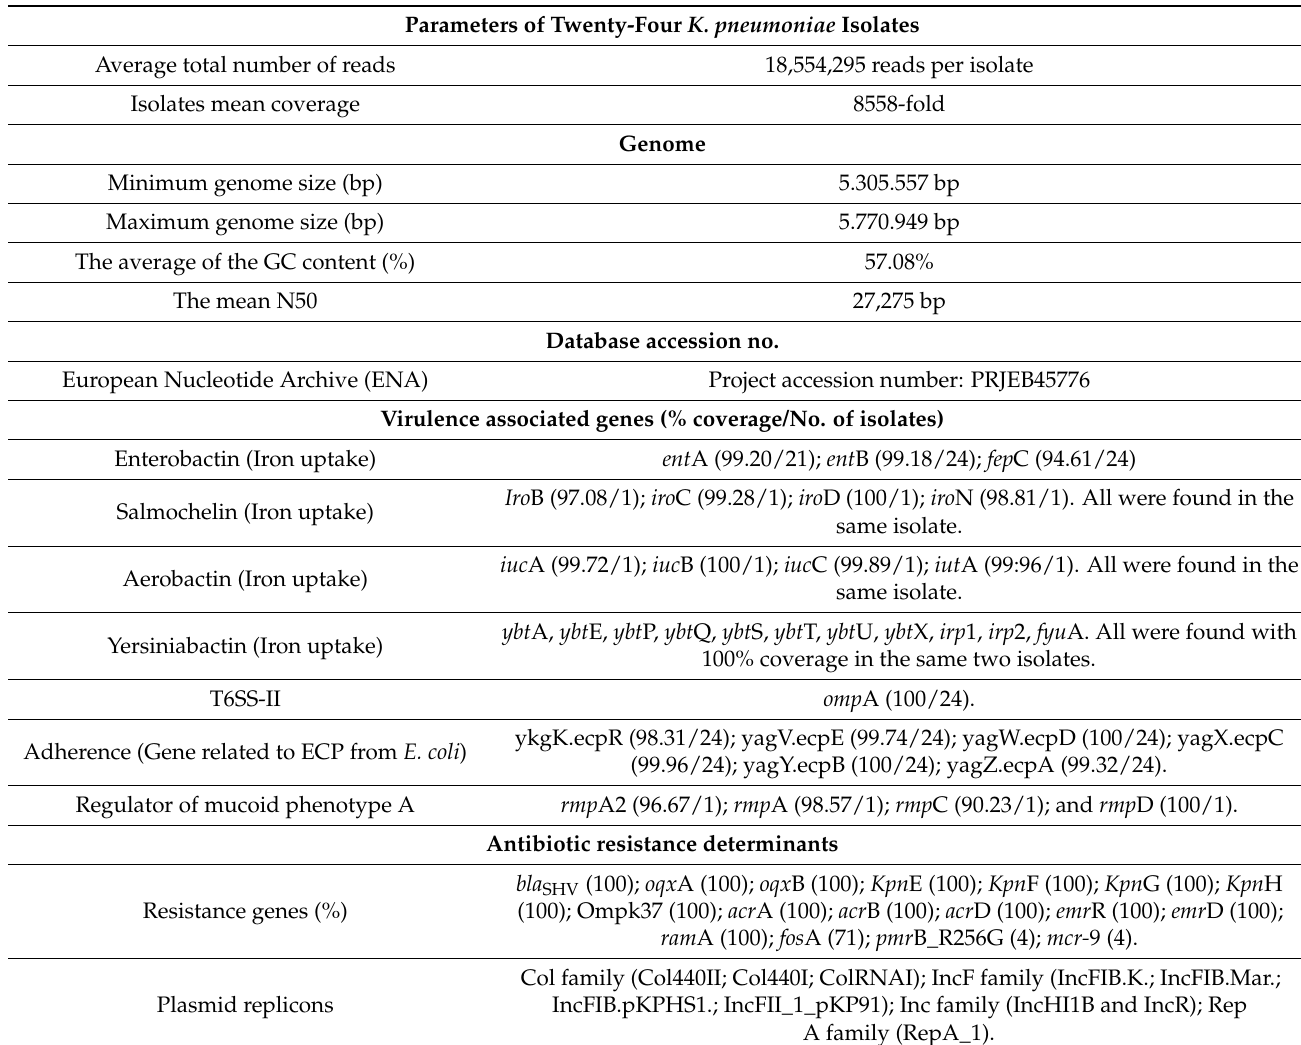
Table 2. Genetic features of 24 K. pneumoniae isolates originating from milk powder samples. Parameters of Twenty-Four K. pneumoniae